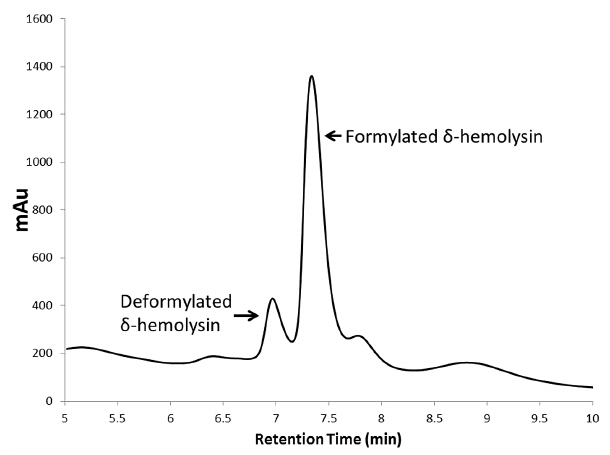
FIGURE 4 | High performance liquid chromatography chromatogram of deformylated and formylated δ -hemolysin present in a USA500 (NRS385) S. aureus culture supernatant. Quantification of either the total peak height or peak area allows for accurate quantification of δ -hemolysin production in cultures grown in the presence (or absence) of QSIs.This technique is also very useful in dose-dependent activity studies on